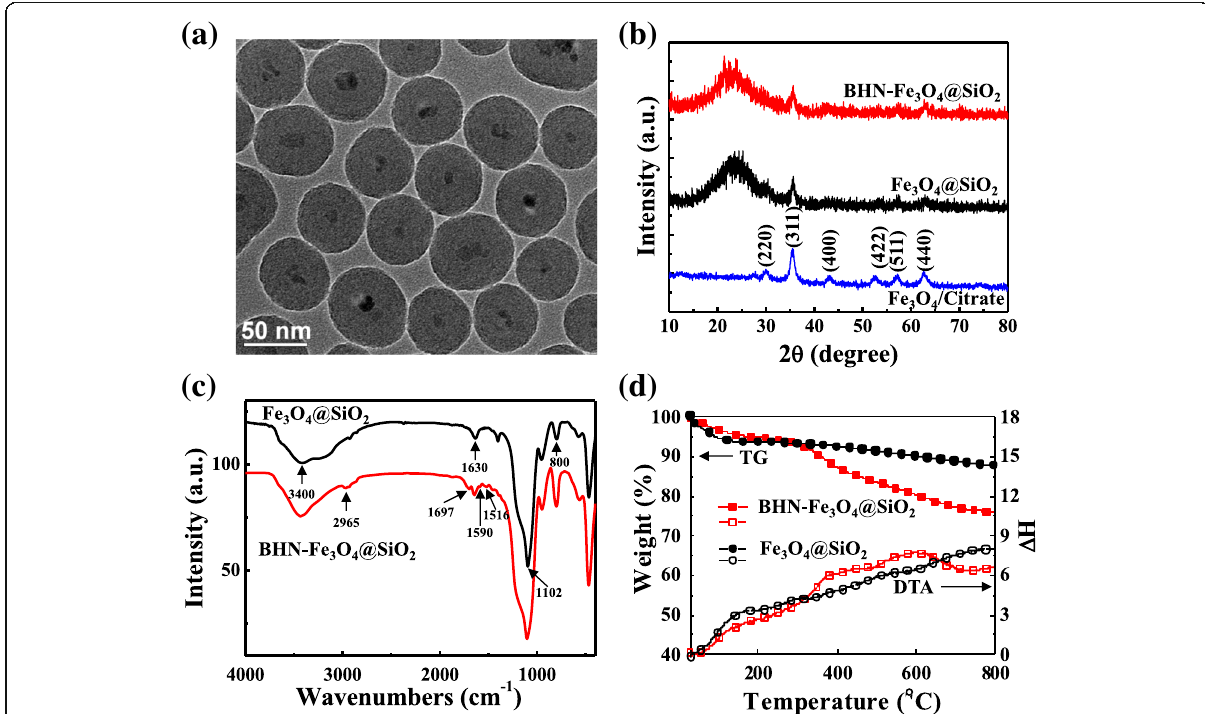
Fig. 2 a TEM image of BHN-Fe 3 O 4 @SiO 2 (the scale bar is 50 nm.). b XRD patterns of Fe 3 O 4 /Citrate, Fe 3 O 4 @SiO 2 , and BHN-Fe 3 O 4 @SiO 2 . c FT-IR spectra of